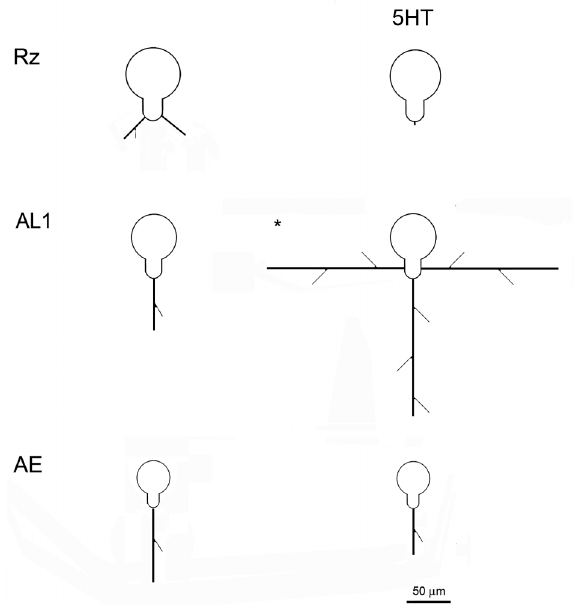
Figure 6. Morphological model of the growth of Retzius (Rz), anterolateral number 1 (AL1) and annulus erector (AE) neurons. Neurite sizes are drawn to scale based on average results. After adding serotonin (5-HT) to the medium, the total neuritic length and the number of primary neurites and rami fi cations were decreased in the Rz neurons. In AL1 neurons, total neuritic length (TNL) and number of rami fi cations increased. There was no clear effect on AE motoneurons. The asterisks indicate 95% statistically signi fi cant differences in TNL with the unpaired t